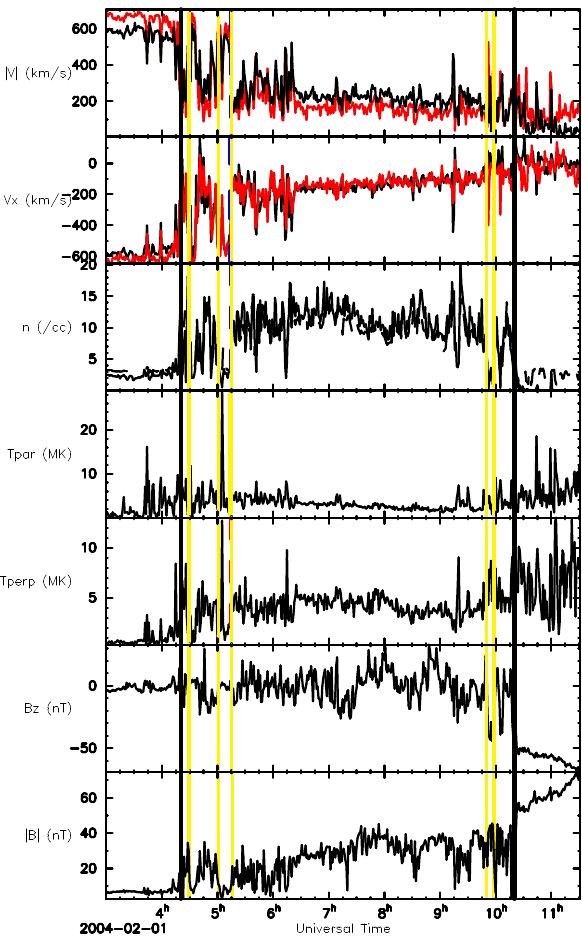
Fig. 2. Selecting the magnetosheath crossing: Electron (red), ion and magnetic field (black) data for a magnetosheath crossing on the February 1st 2004. The spacecraft first encounters the mag- netosheath at approximately 4:18 UT, (thick blue line). There are two subsequent re-entries of the spacecraft into the solar wind en- vironment after this time, during the periods 04:25–04:40, 04:53– 05:14 UT, and an entry by the spacecraft into the magnetosphere between 09:50–09:58. These intervals are indicated by the dashed blue lines and are excluded from our magnetosheath data